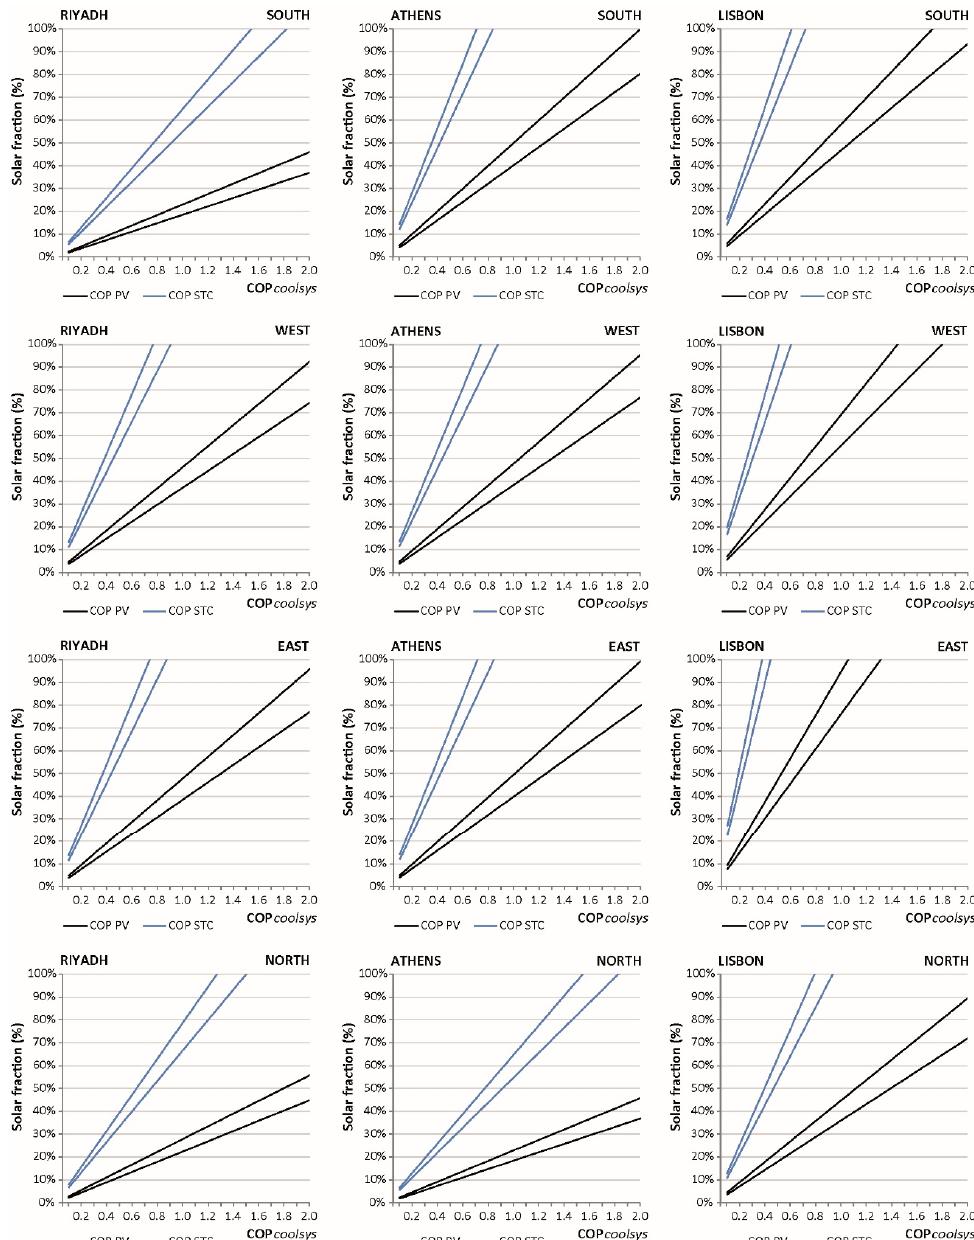
Figure 2. Comparison between solar fraction and COP (electric and thermal) of a given solar cooling system in warm, dry climates.